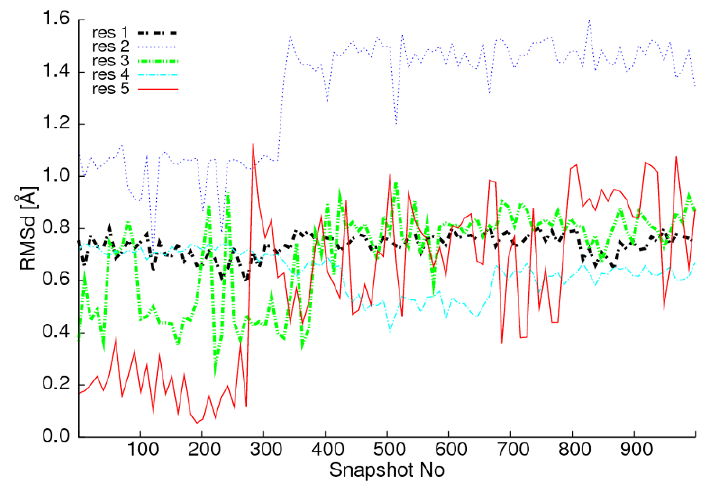
Figure 3. Plot of RMSd changes of DA-DLac during unconstrained MD.